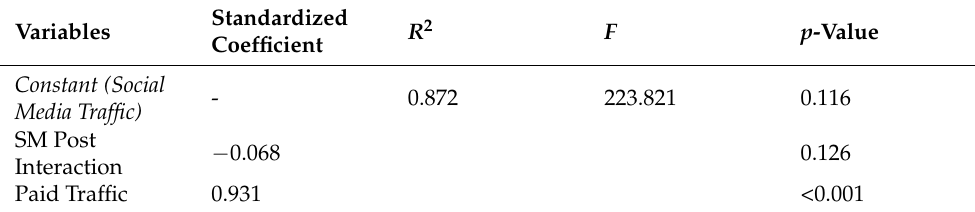
Table 3. Regression analysis for H1.